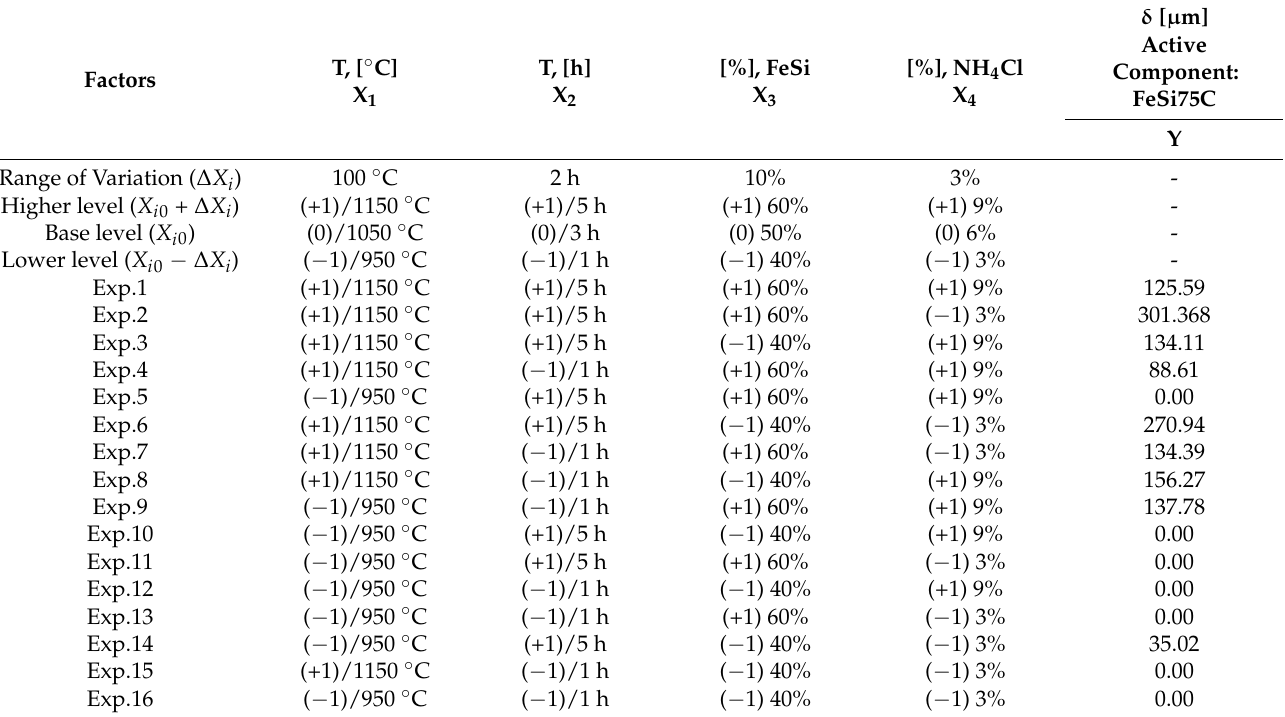
Table 2. Complete factorial experiment (EFC) 2 n > 2 4 ; experimental conditions and results obtained.